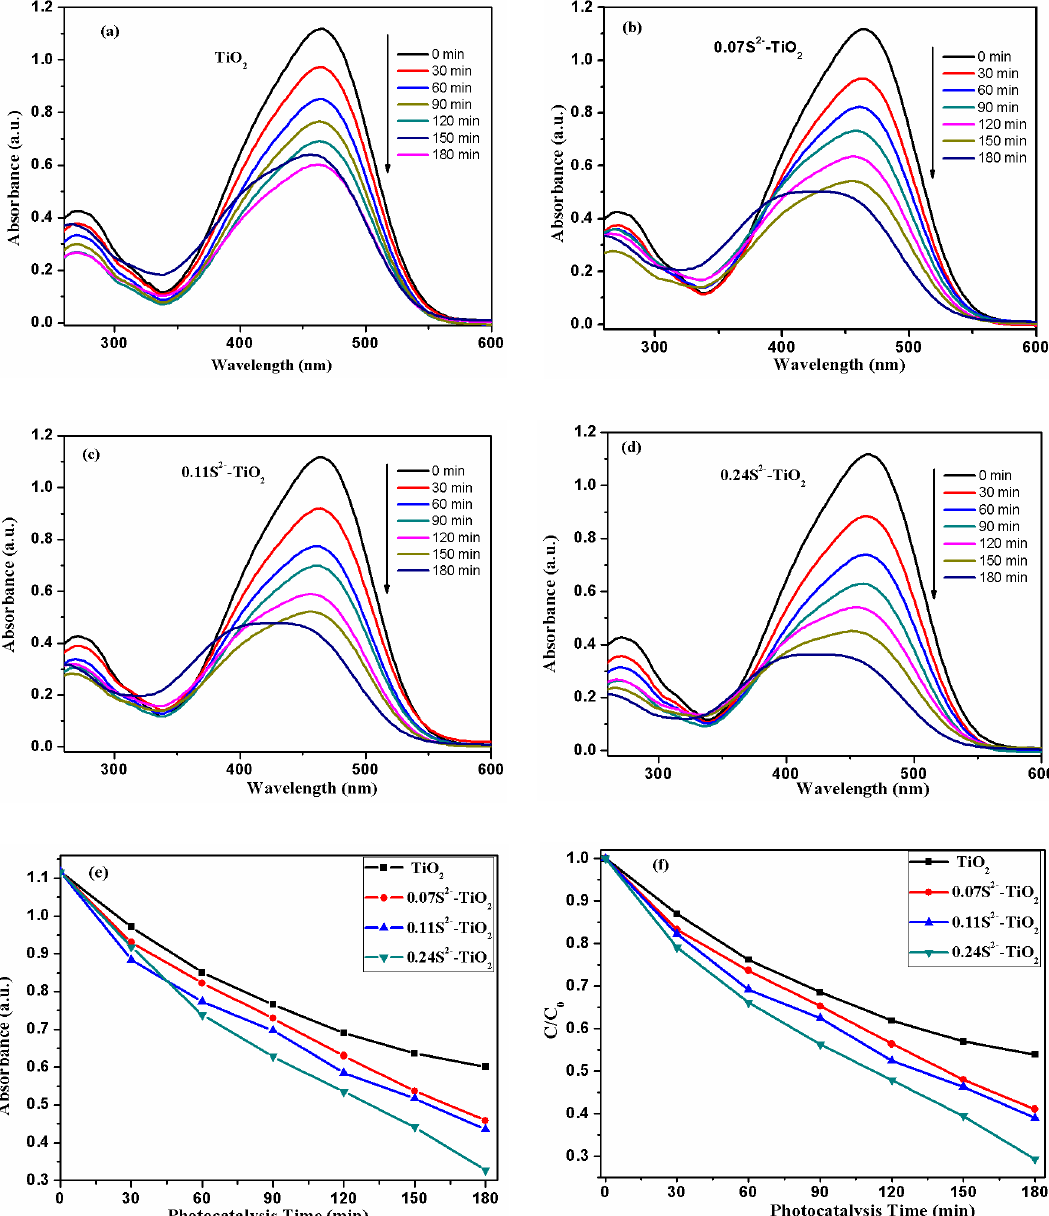
Figure 8. ( a – d ) UV-vis absorption spectrum of methylene orange (MO) solution by different samples under 25 W mercury lamp. ( e ) C t /C 0 plots of MO solution by different samples. ( f ) Corresponding photocatalytic degradation curves of MO solution by different samples.